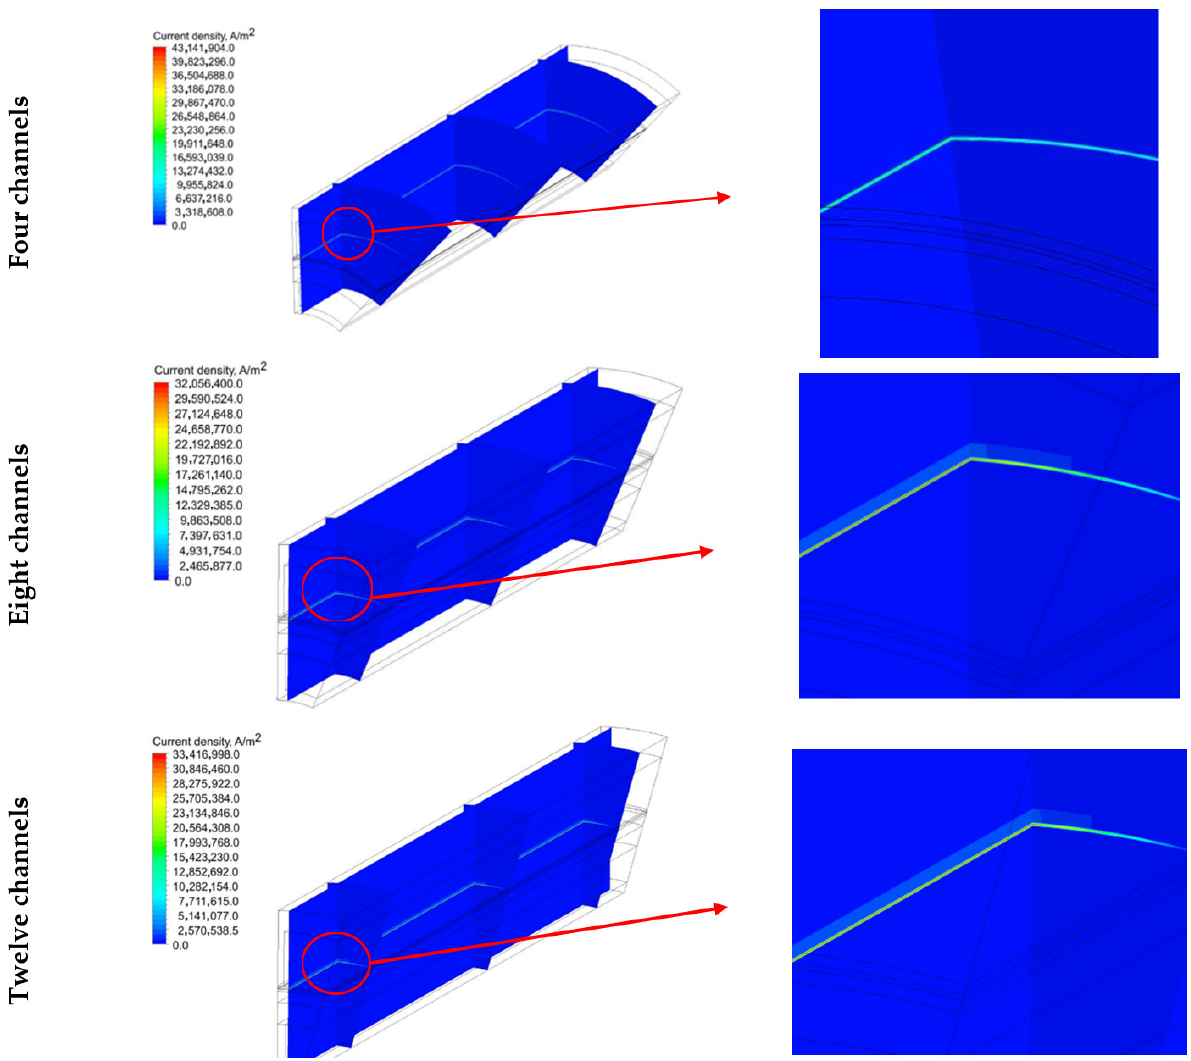
Figure 12. Current density distribution contour through the cell.